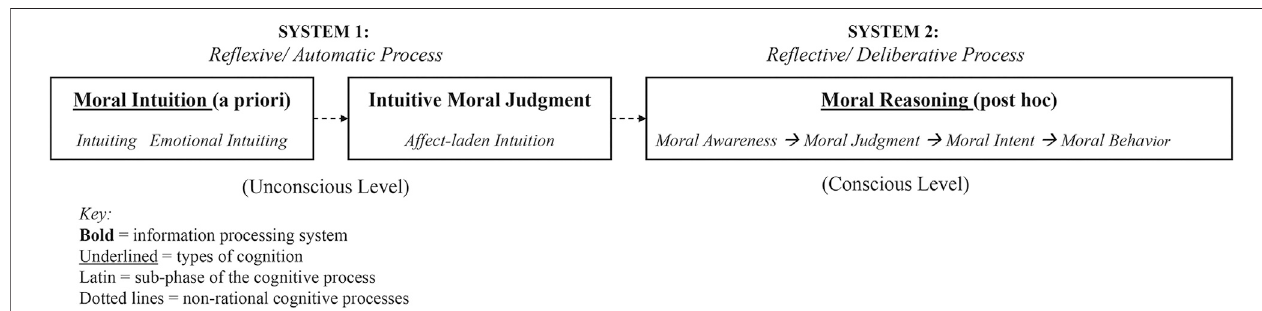
FIGURE 2 | Dual-process model of ethical decision-making (Source: Zollo, 2020, p.7).